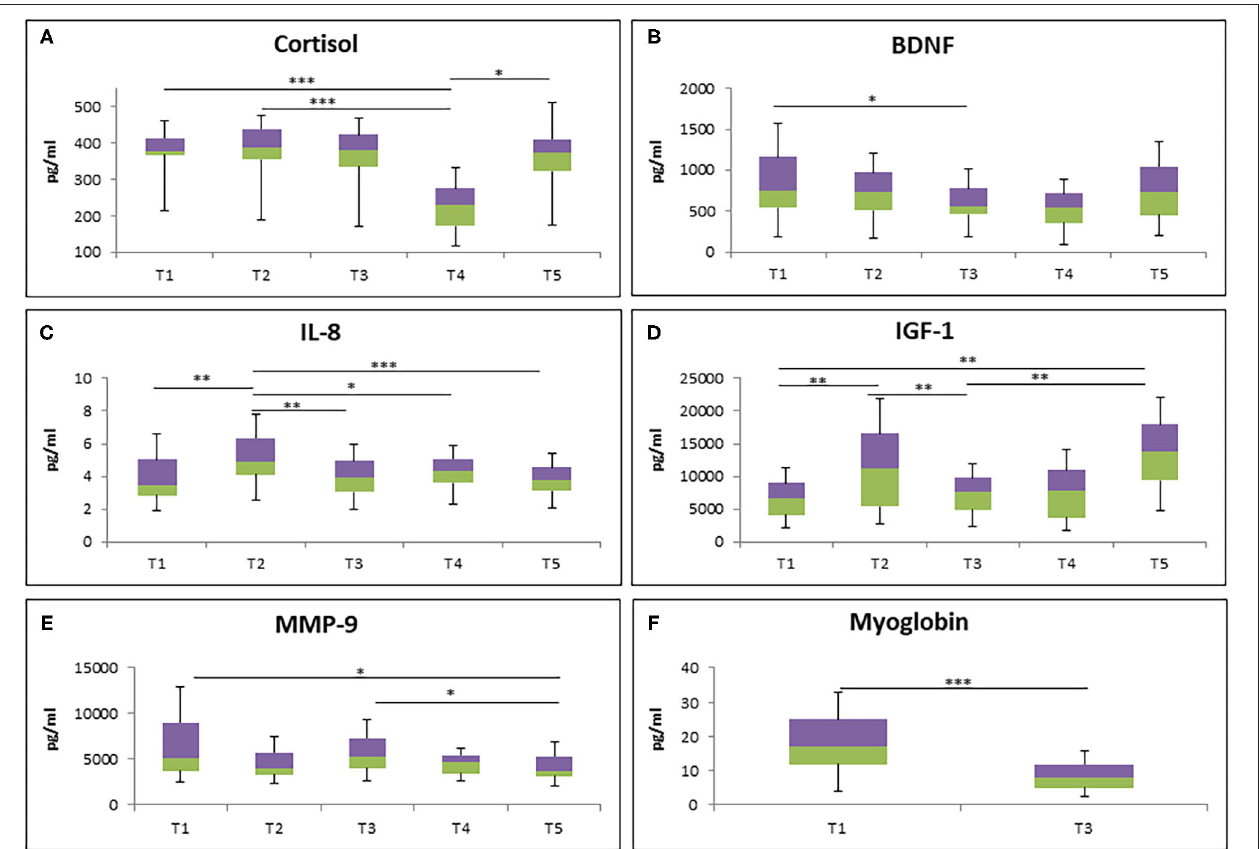
FIGURE 2 | The level of cortisol (A) , BDNF (B) , IL-8 (C) , IGF-1 (D) , MMP-9 (E) , and myoglobin (F) during RF in all participants ( N = 34). * p < 0.05, ** p < 0.01, *** p < 0.001.